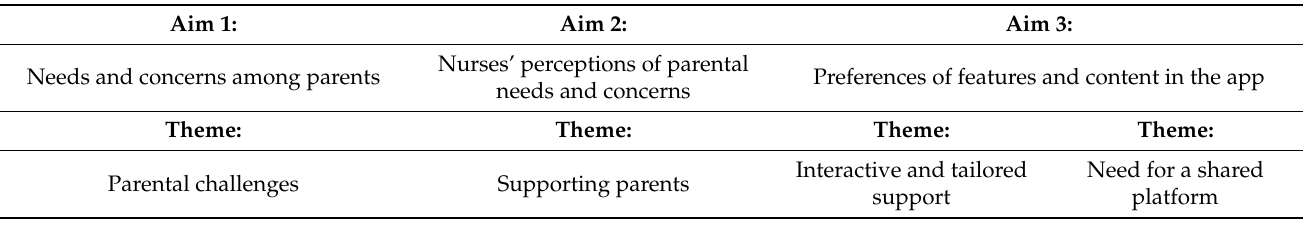
Table 2. Study aims and corresponding themes, representing both the parents’ and nurses’